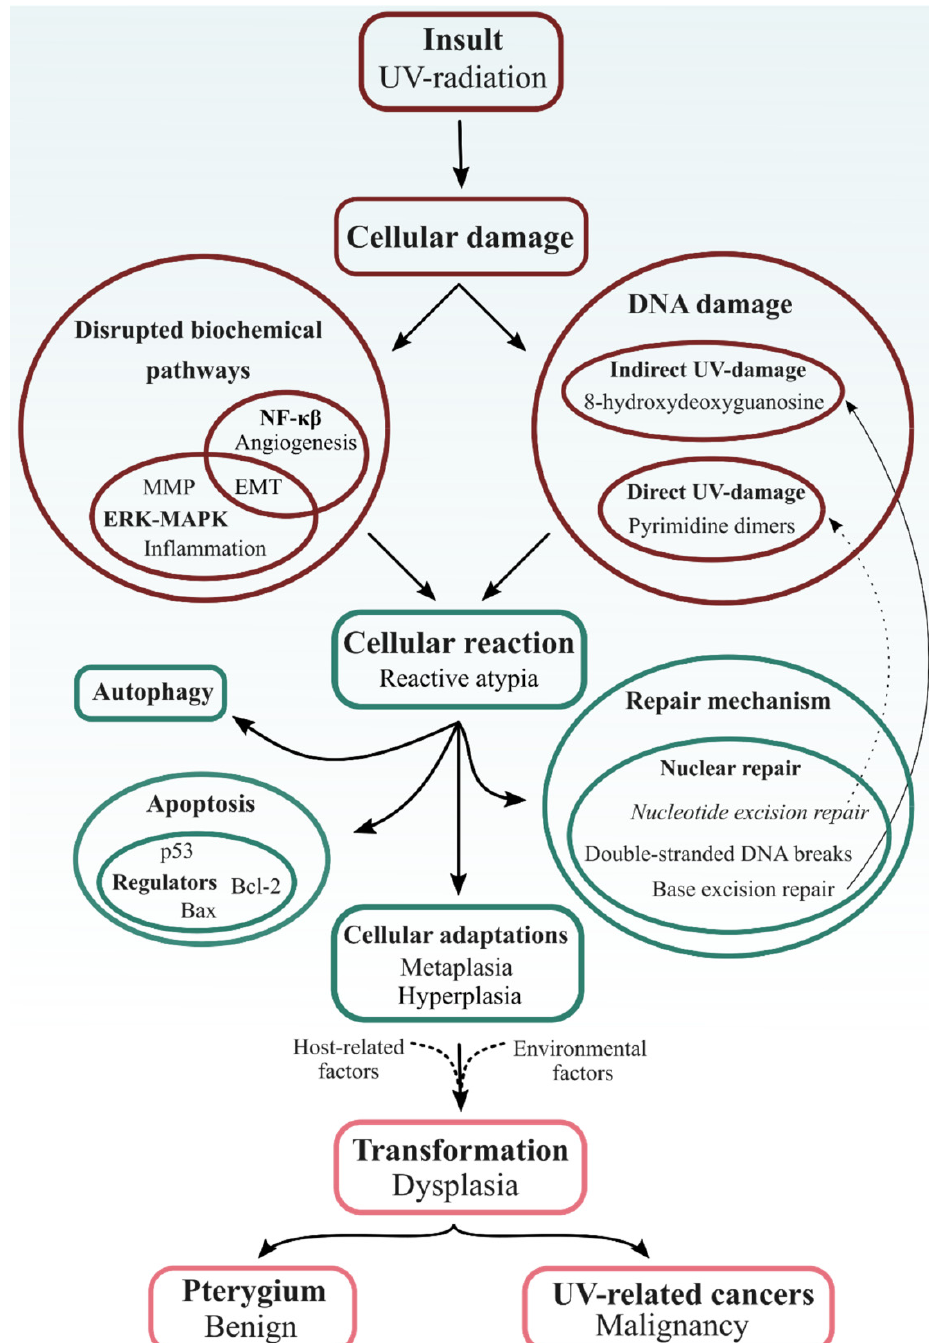
Figure 2. Schematic representation of the similarities between pterygium, ocular surface squamous neoplasia and epidermal cancer, starting from the initial insult (i.e., UV radiation) to the damage shared between the UV-related lesions and their uniform cellular reactions. The difference between pterygium and true malignant cancers lies within the final step. EMT, epithelial-to-mesenchymal transition; ERK-MAPK, extracellular-signal-regulated kinase–mitogen-activated protein kinase; MMP, matrix metalloproteinases.